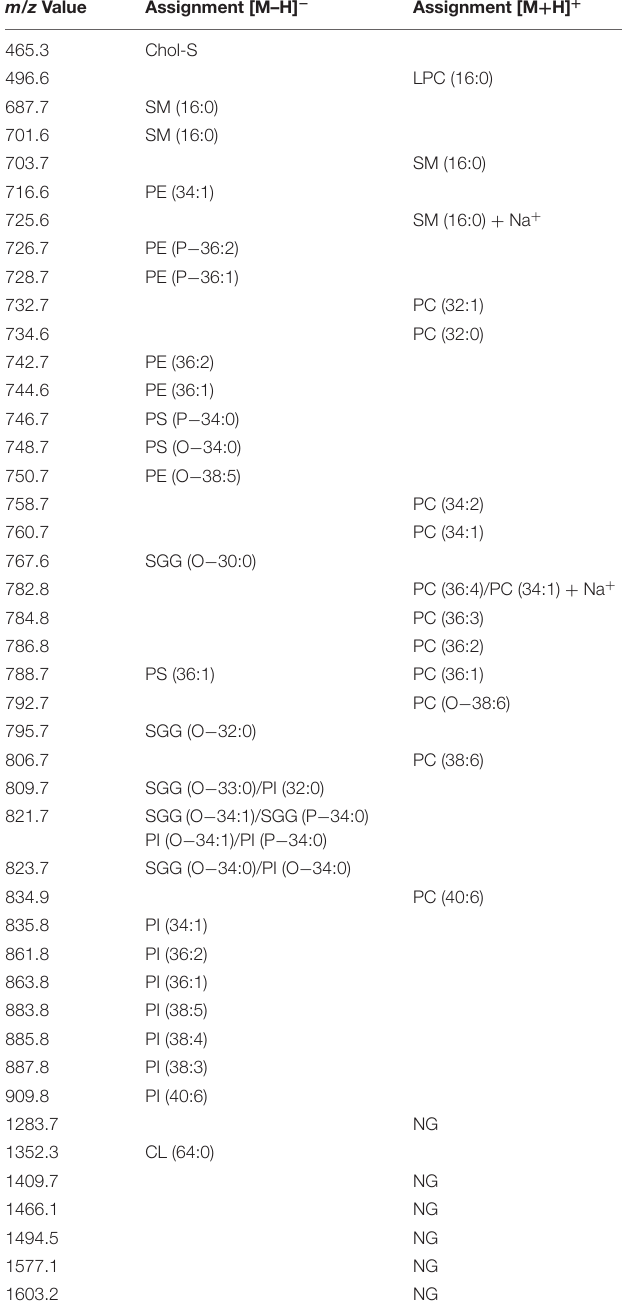
TABLE 1 | Assignments of m/z values detected in MALDI-TOF mass spectra of lipids from